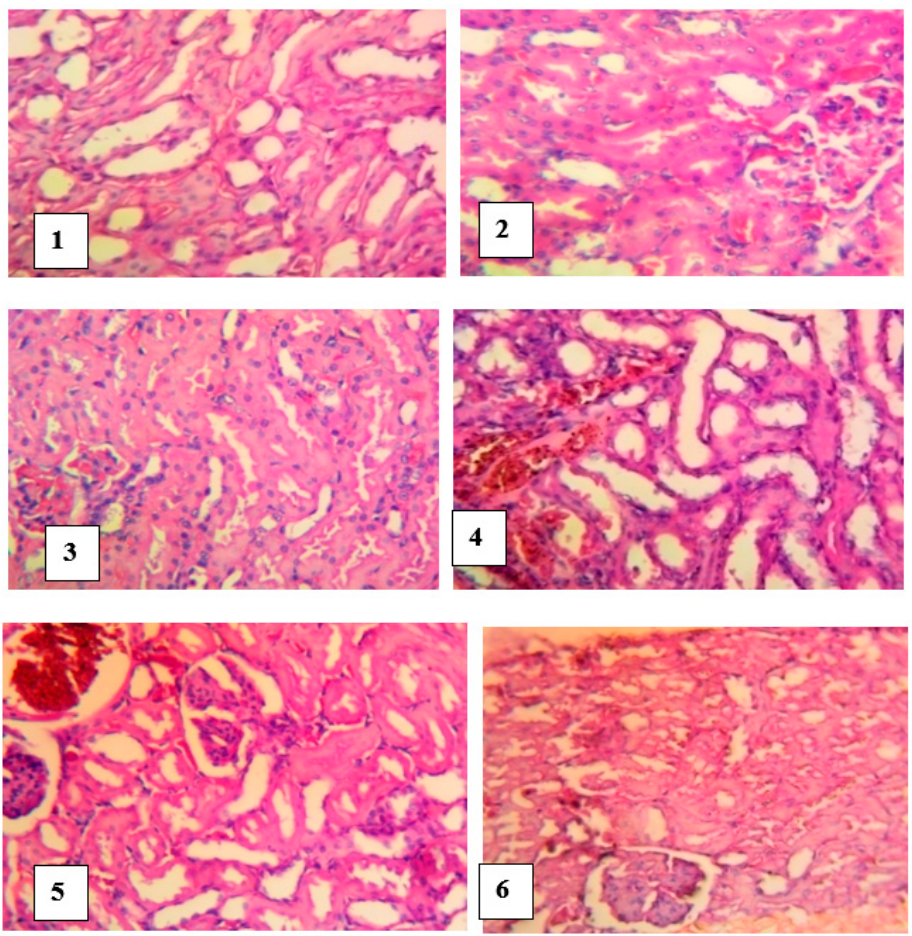
Figure 8. Histological examination of the kidneys of envenomed treated rats (×400). Group 1 (normal control): Normal and no foci of flattening of tubular epithelial cells, Group 2 (venom control): a cystic dilated appearance of foci of tubules, Group 3 (antivenom control): tubules appeared normal, Group 4 (venom/200 mg/kg extract): extensive foci of flattening of epithelium of tubules, Group 5 (venom/400 mg/kg extract): focus of marked flattening of epithelium of tubules, Group 6 (venom/600 mg/kg extract): few foci of tubular epithelial cells.